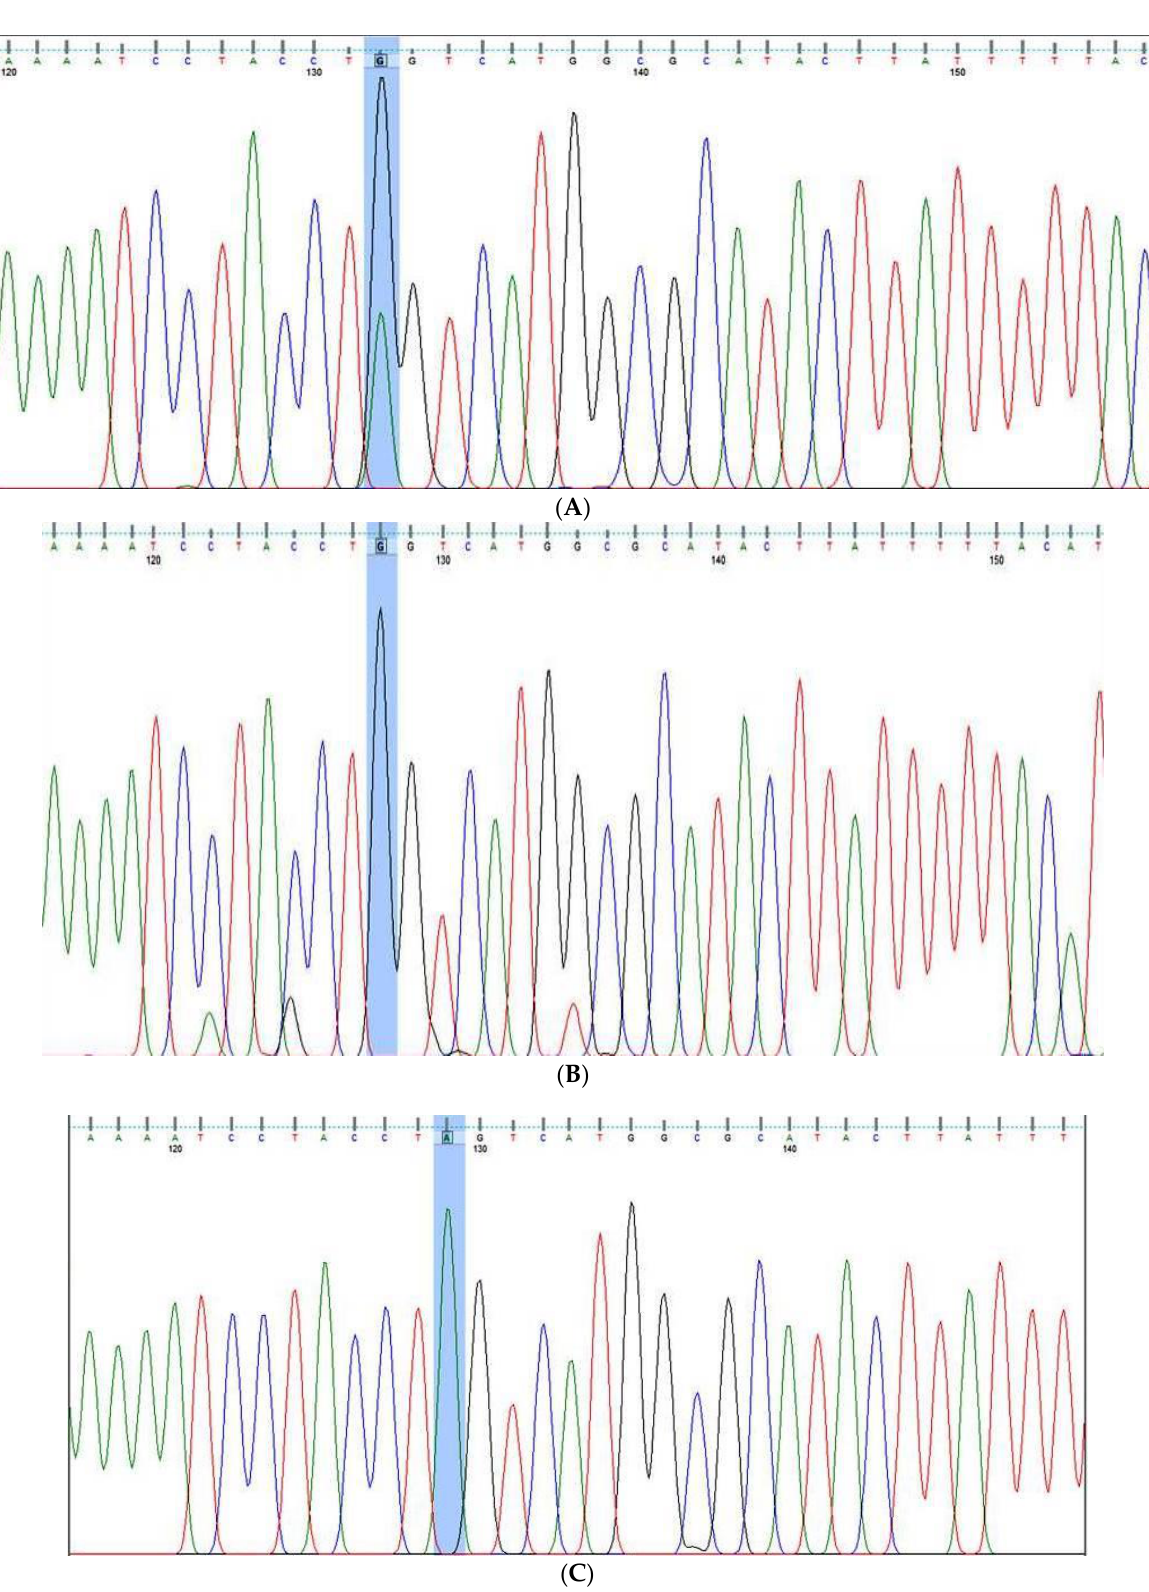
Figure 2. KLF-14 rs972283 G > A genotyping by Sanger sequencing. ( A ): Sanger sequencing for KLF-14 rs972283 genotyping (G/A alleles), ( B ): Sanger sequencing for KLF-14 rs972283 genotyping (G allele); ( C ): Sanger sequencing for KLF-14 rs972283 genotyping (A allele). MDM4 rs11801299 A > G gene variation: The exterior primers A band of 468 bp was